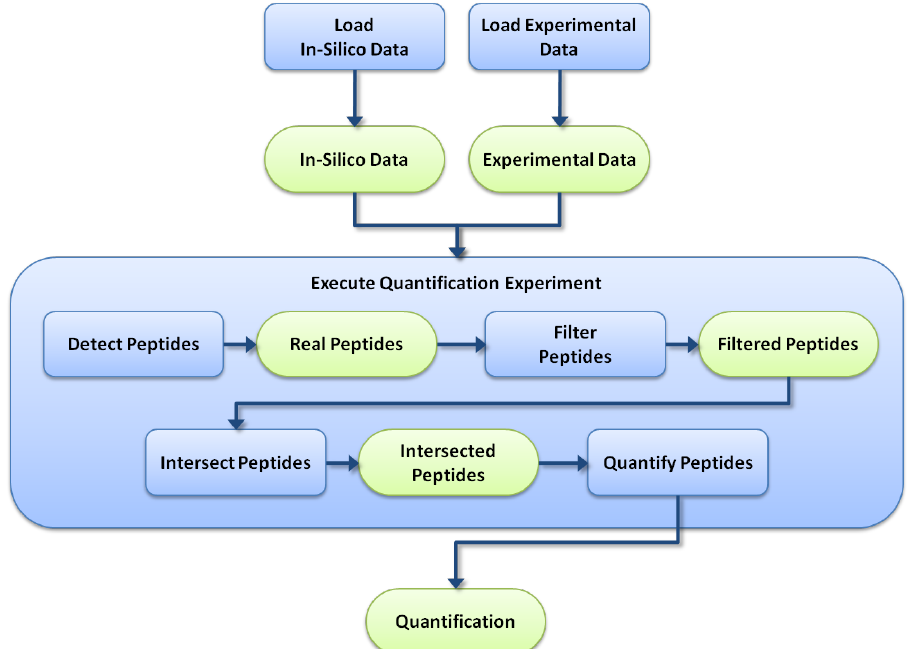
Figure 6: DPD quantification experiment